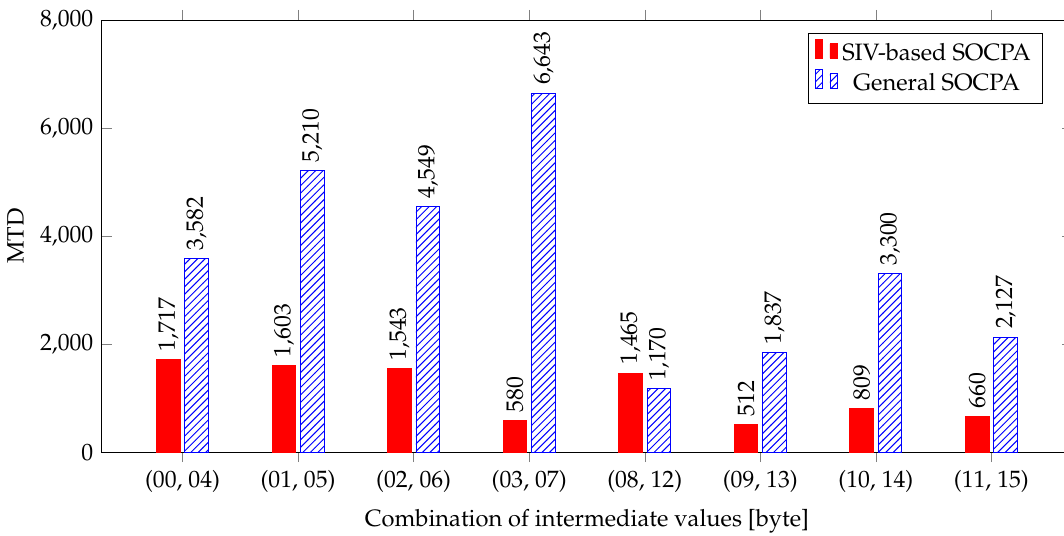
Figure 7. Minimum trace to disclosure for MixColumns for a combination of 1st and 5th bytes (Production-Combining).